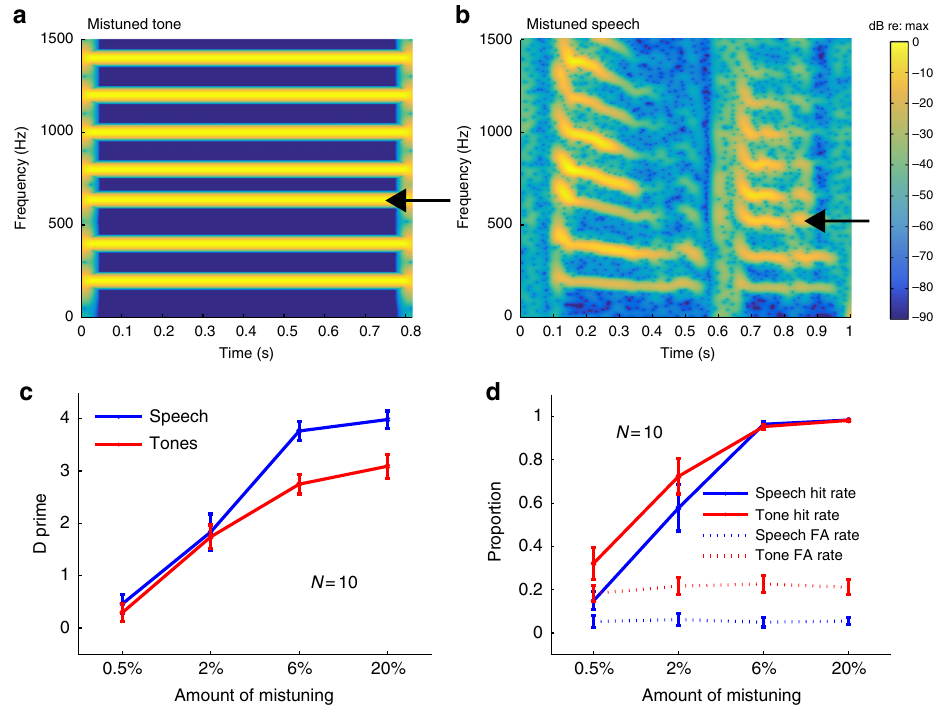
Fig. 2 Detection of mistuning of the third harmonic in speech utterances and in complex tones (Experiment 1). a Spectrogram of example tone stimulus with the third harmonic mistuned upward by 6%. Arrow indicates mistuned harmonic. b Spectrogram of example speech stimulus with the third harmonic mistuned upward by 6%. Arrow indicates mistuned harmonic. c Sensitivity to mistuning in tones and speech. d Hit and false alarm rates for tones and speech. Hits were de fi ned as correct responses on trials in which the harmonic was mistuned, and false alarms were de fi ned as incorrect responses on trials in which the harmonic was not mistuned. False alarm rates were calculated from the half of the trials in which there was no mistuning, randomly assigned to the four conditions. Error bars here and in c plot